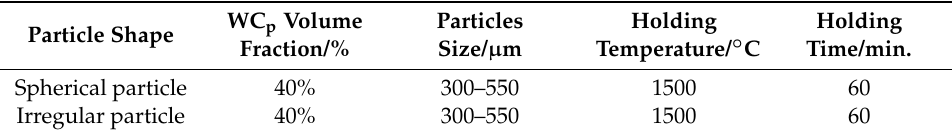
Figure 2. A schematic diagram of the preparation of WC p /iron matrix composites. ( a ) The heating schematic diagram of the tube furnace; ( b ) The morphology of spherical (left) and irregular (right) WC p . Table 1. The process parameters of WC p /iron matrix